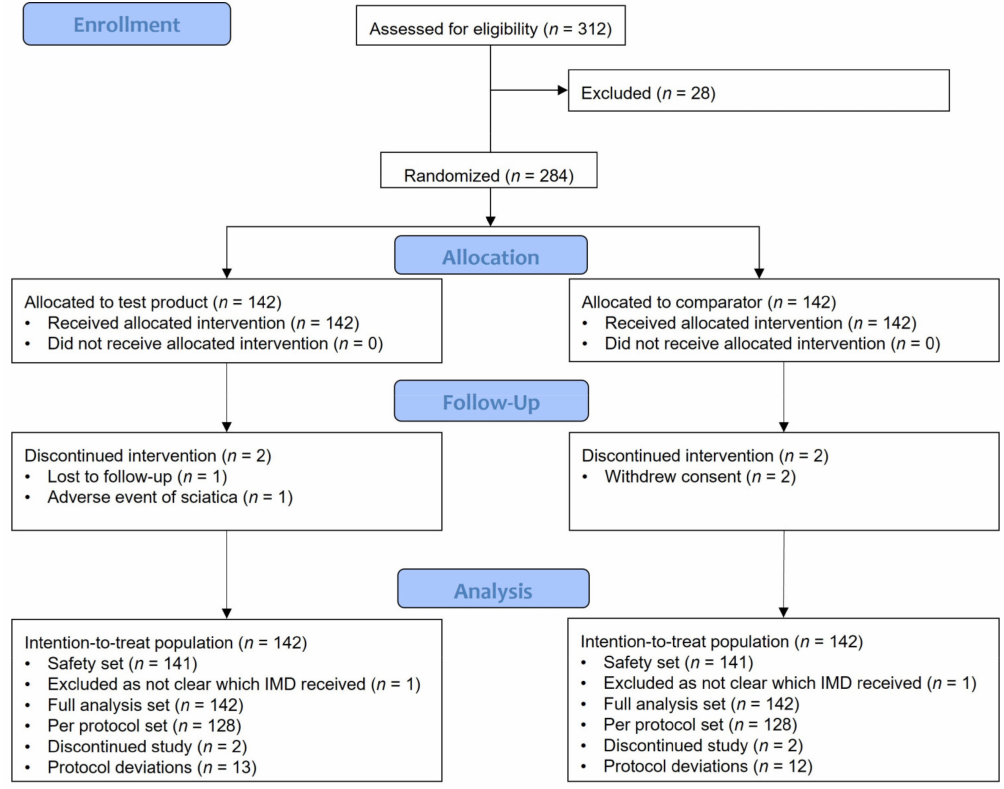
Figure 1. Flowchart illustrating the number of patients included in the study. IMD, investigational medical